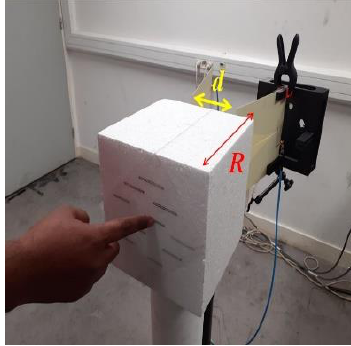
Figure 11. Measurement setup for the identification and touch sensing.